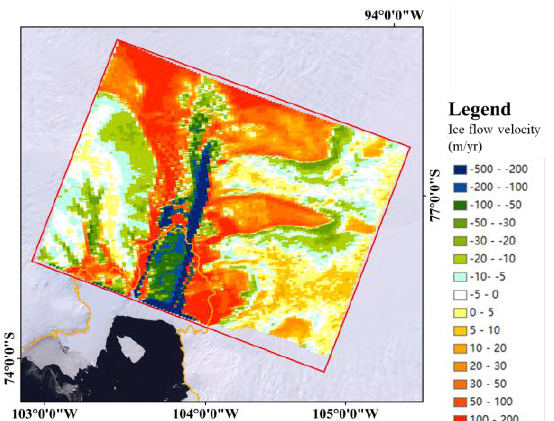
Figure 5 . Ice flow velocity difference between our result and Rignot’s (Mouginot et al., 2017).